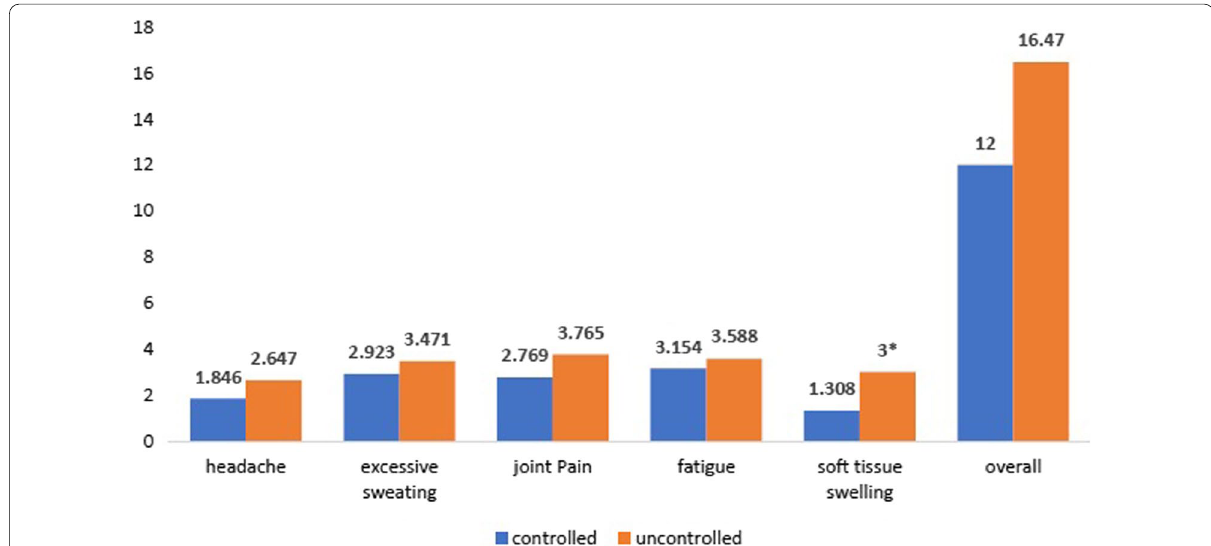
Fig. 2 PASQ symptoms scores in biochemically controlled vs biochemically uncontrolled groups